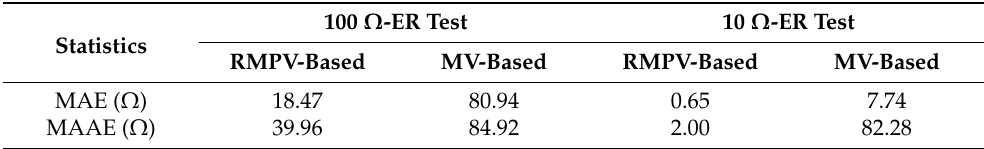
Table 2. Statics of ISC resistance estimation